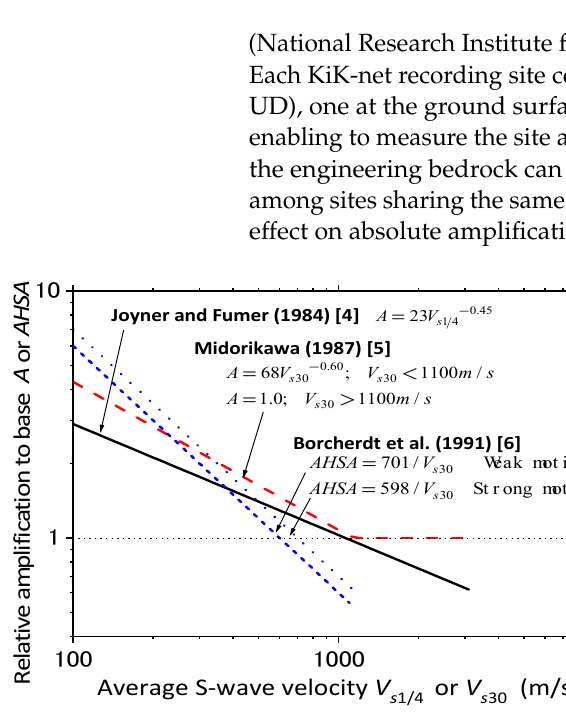
Figure 2. Empirical formulas on site amplifications using average S-wave velocities near the surface.